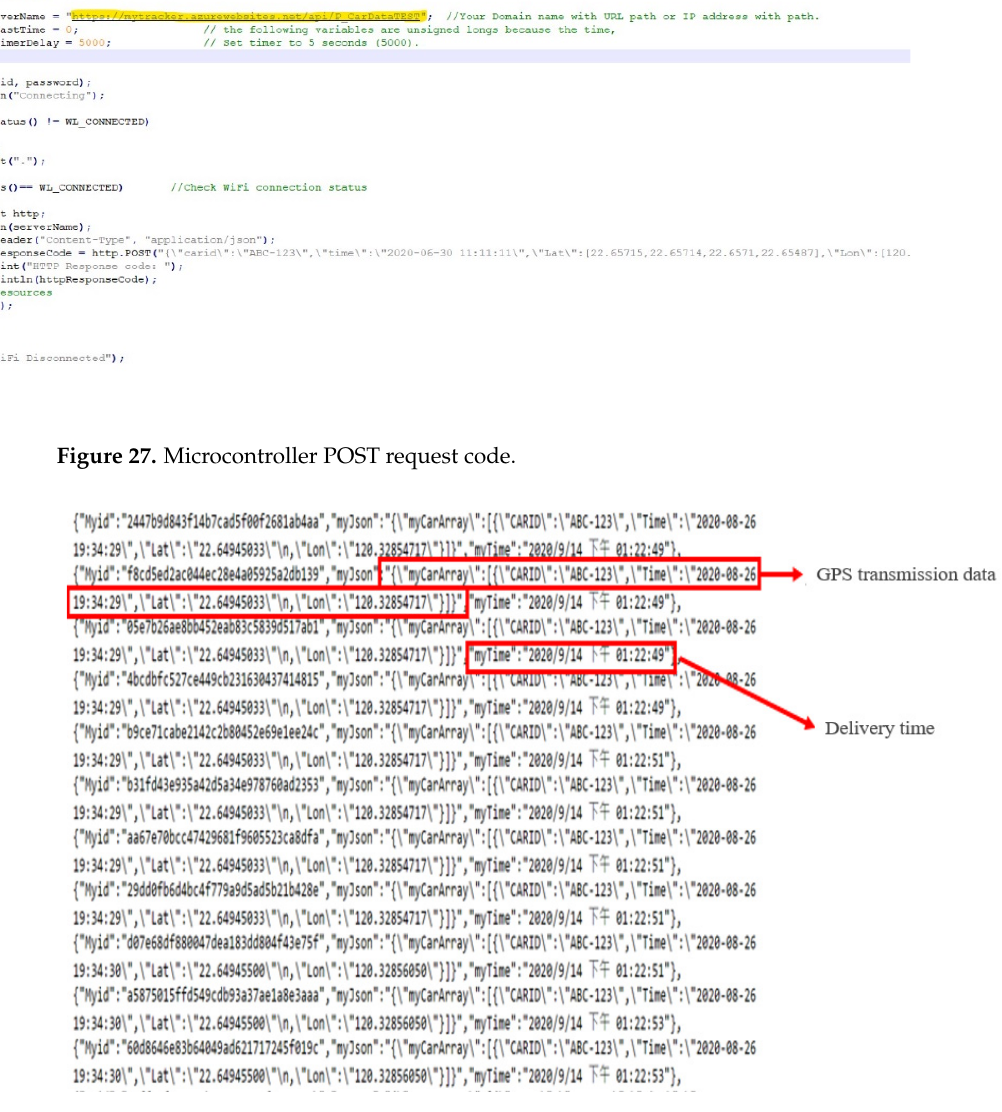
Figure 28. Result received by the backend server database.